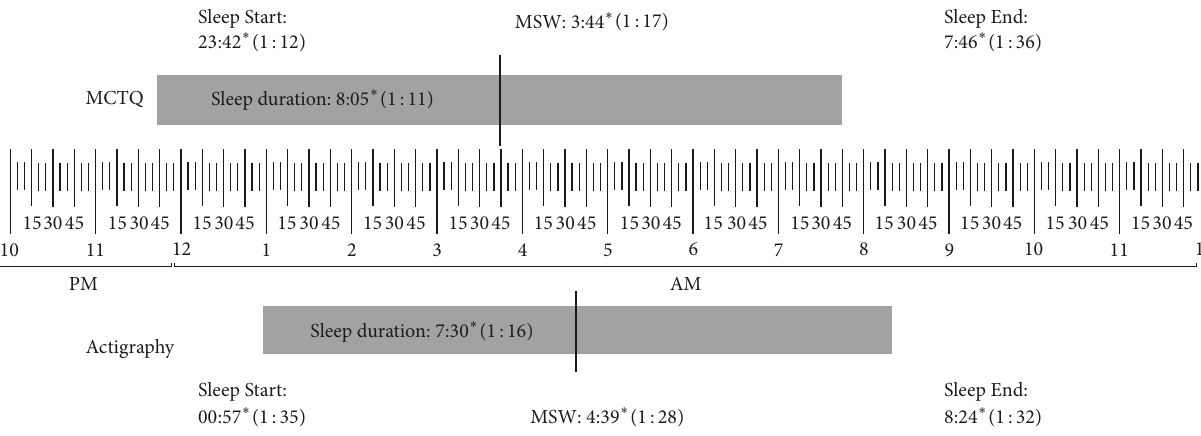
Figure2:MeansandstandarddeviationsofMCTQandactigraphyonworkdays.MCTQ:Munichchronotypequestionnaire.MSW:midpoint of sleep on work days. SD: standard deviation. Significant differences between the two measures were marked with an asterisk.